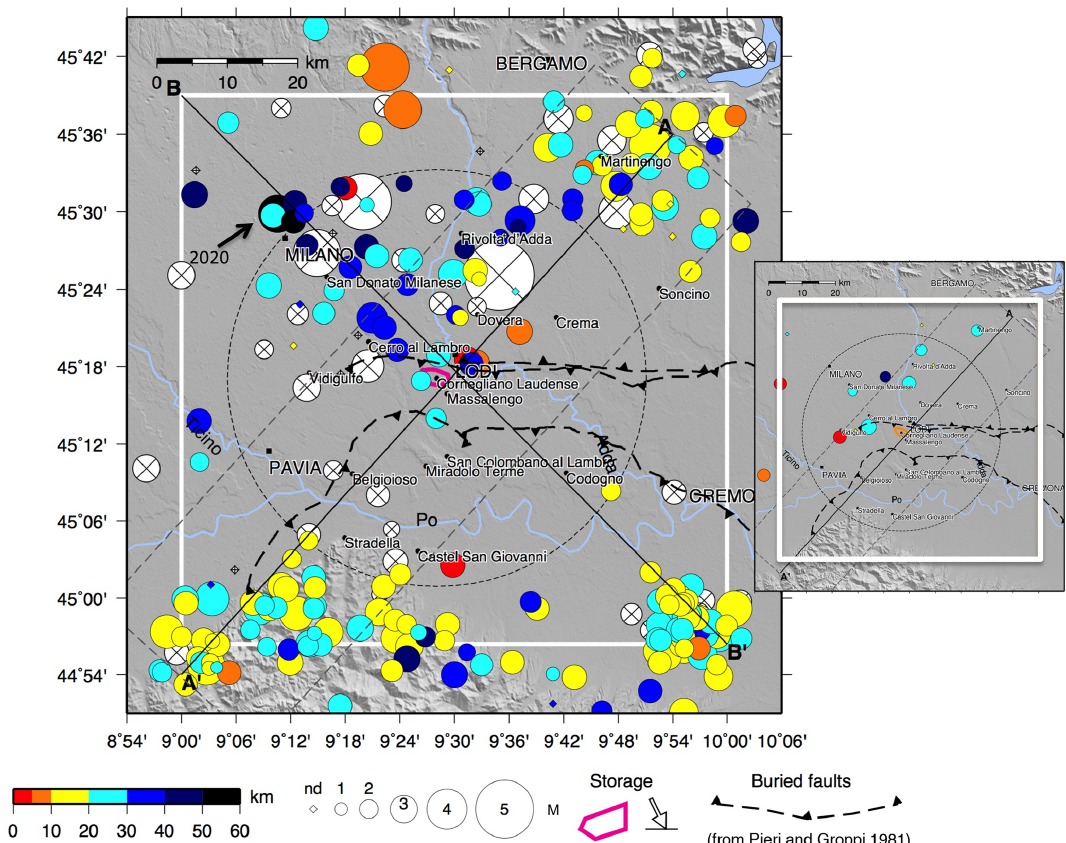
Figure 8. Relocated earthquake catalogue for the study area, for the period 1951–2019. The black arrow and label show the location of the 17 December 2020 Milan earthquake, relocated in this study too and corresponding to the solution given by model 4 in Table 3. Main panel: epicentral map of events that fall approximately in the target area (white frame); inset: events discarded as probable fake locations. The 30km distance from the reservoir is marked by a black dashed circle; the main buried faults are taken from Pieri and Groppi (1981). White crossed circles represent earthquakes with large standard errors in location (horizontal error ERH > 5km or vertical error ERZ >